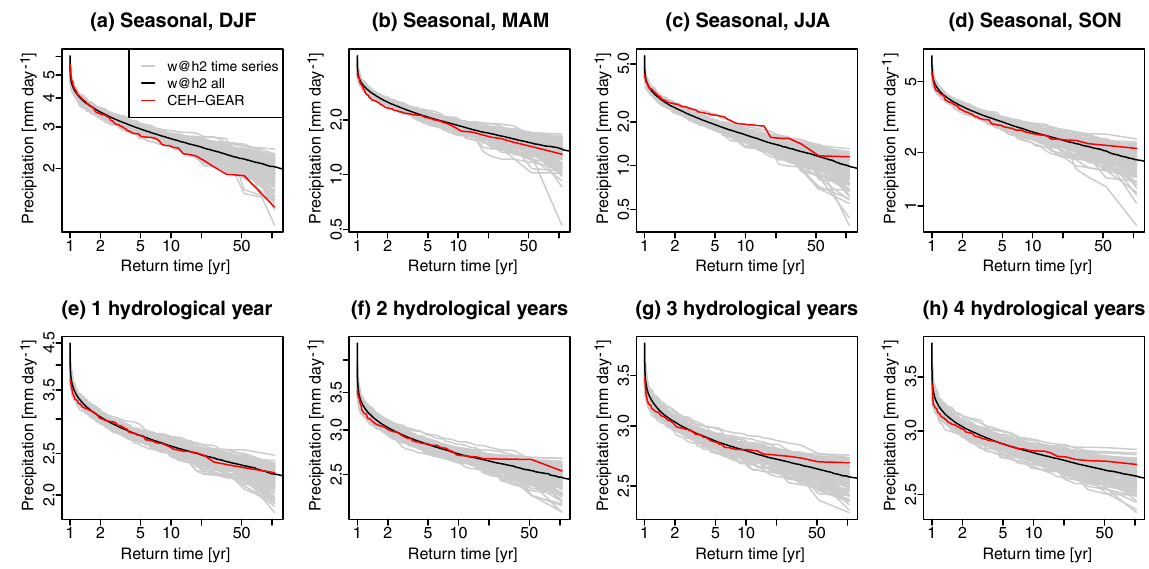
Figure 6. Return time plots of (a–d) low seasonal precipitation and (e–h) low precipitation accumulated in 1–4 consecutive hydrologi- cal years, for Great Britain averages from 1900 to 2006. (red) CEH-GEAR, (grey) individual w@h2 time series and (black) all w@h2 time series pooled together. For each time series, seasonal or (multi-)year averages of precipitation were computed and spatially aggregated over Great Britain prior to the computation of return values.